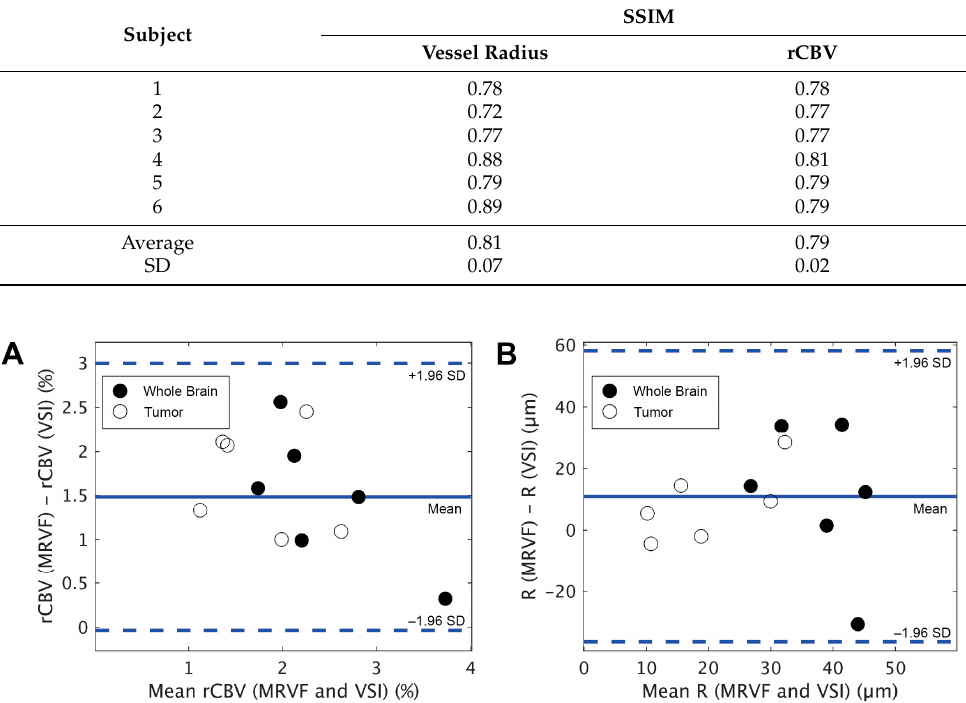
Figure 6. ( a ) and ( e ) are the vessel radius, R (in μ m) and rCBV (in %) maps of the synthetic image